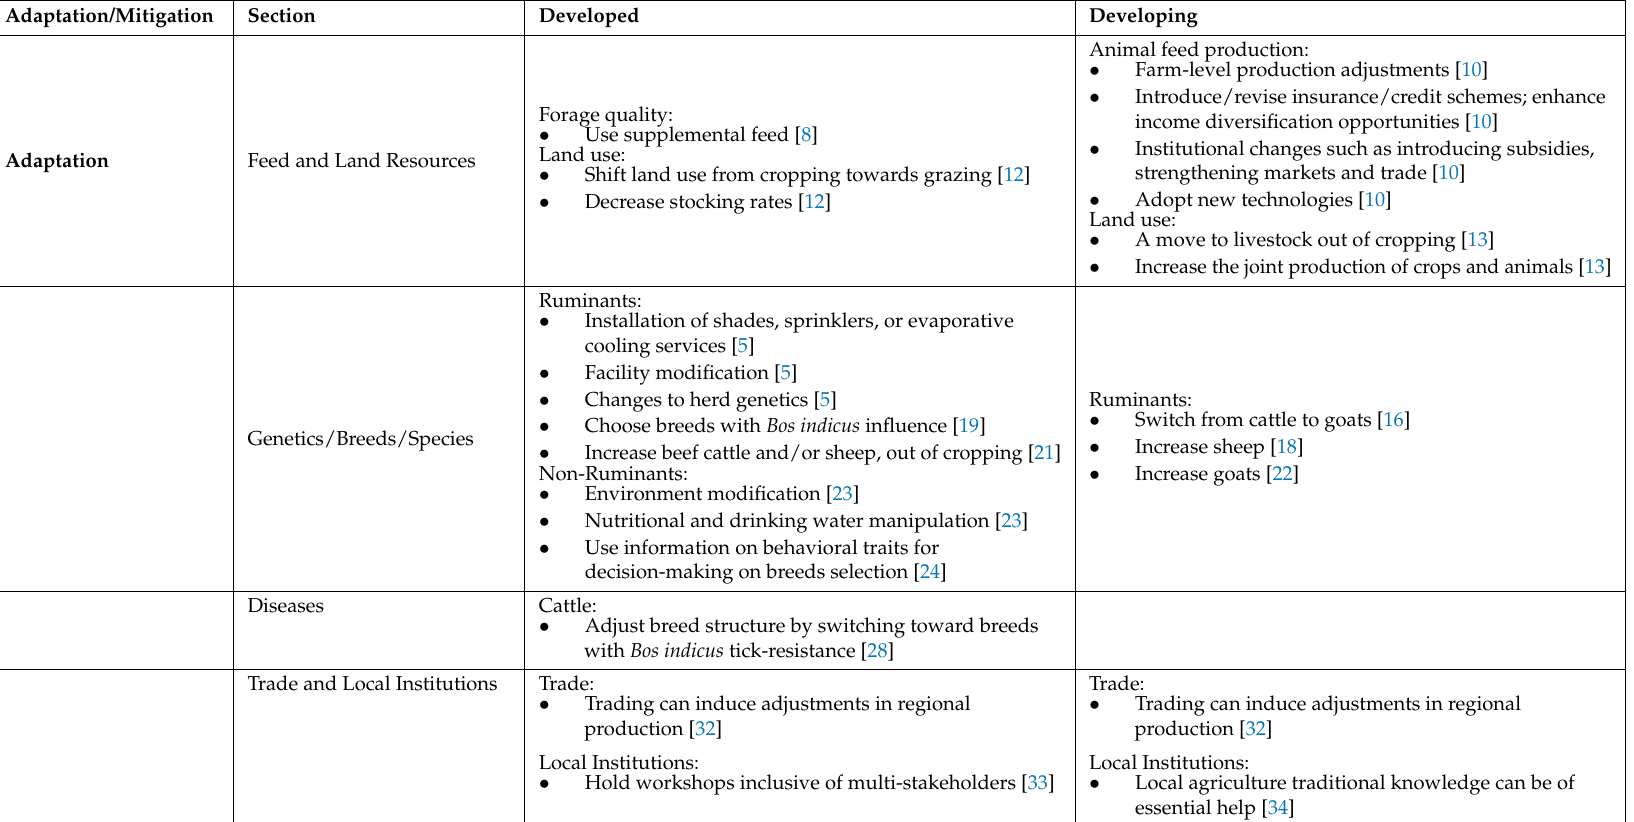
Table 1. Mitigation and Adaptation Strategies for Developed versus Developing